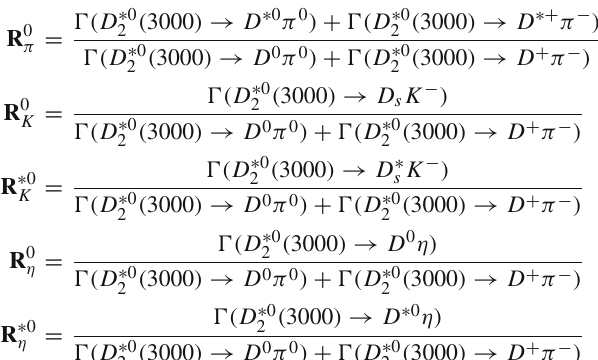
Table 10 The strong decay widths (in MeV) for resonance D ∗